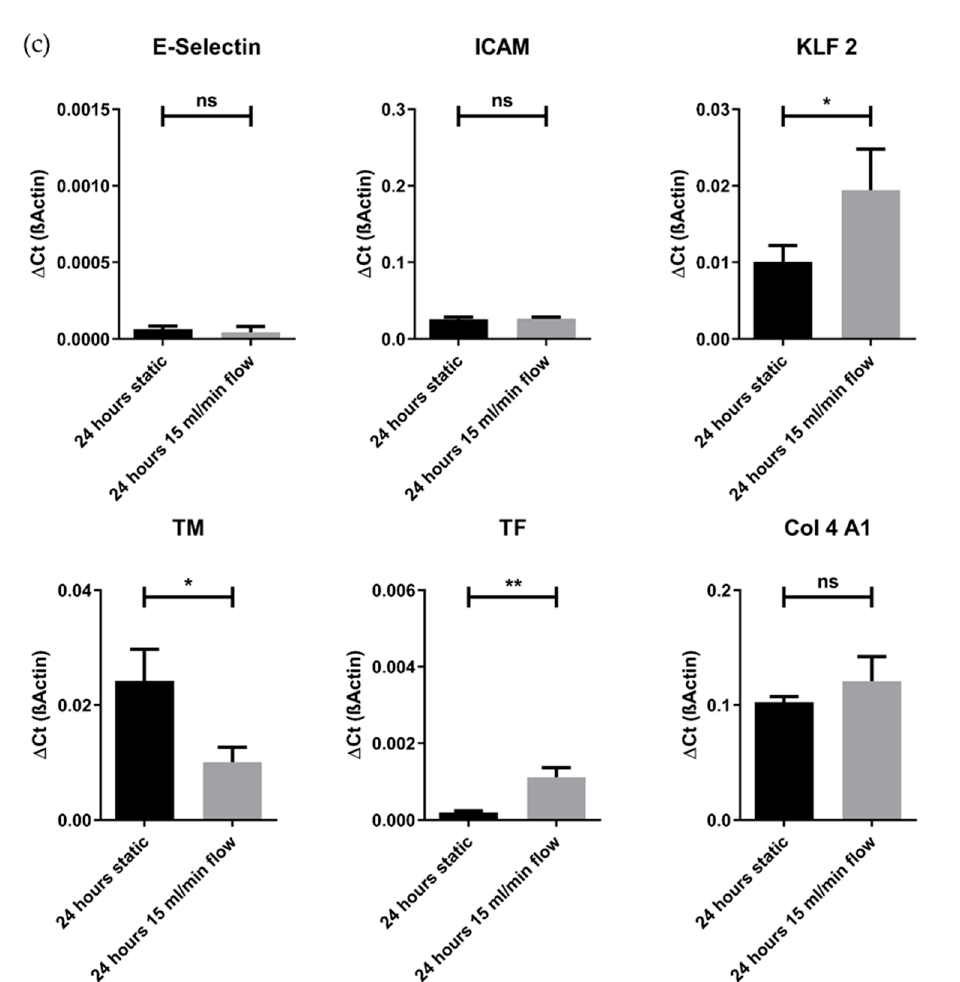
Figure 4. Comparison of pCECs under static and flow conditions. ( a , b ) Calcein staining of viable pCECs (green) after 24 h of static ( a ) or dynamic (15 mL/min flow) ( b ) conditions; ( c ) qRT-PCR analysis of flow-exposed pCECs regarding inflammatory activation (E-Selectin and ICAM), shear stress response (KLF 2), thrombogenic state (TM and TF) and matrix synthesis (Col 4 A1). Gene expression levels of the flow-exposed group were compared to the static control groups using an unpaired t -test. For abbreviations of gene names, see Table 2. Results are given as mean with SD ( n = 3) (* p < 0.05; ** p < 0.01; ns = no significance).